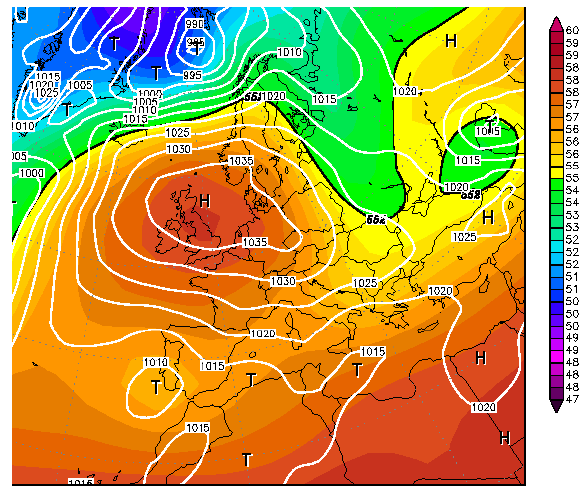
Figure 12.- NCEP reanalisis for 4th November 1987 at 00 UTC. White lines depict isobars (hPa) at sea level. Colors Fig. 12. NCEP reanalysis for 4 November 1987 at 00:00UTC. indicate geopotential at 500 hPa in gpdam according the scale White lines depict isobars (hPa) at sea level. Colors indicate geopo- tential at 500hPa in gpdam according to the scale.